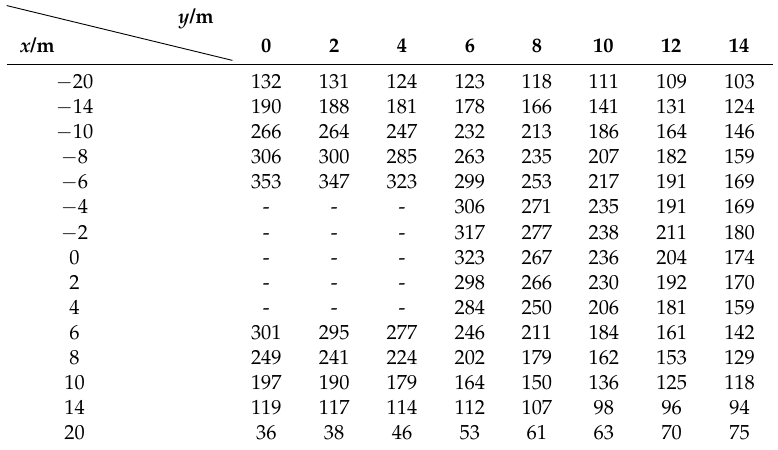
Table 1. Measured data of magnetic field distribution B (μT) .